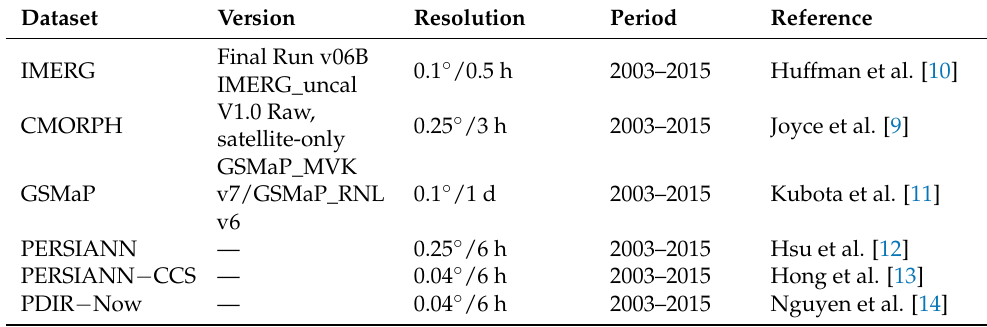
Table 1. Summary of SPPs used in this